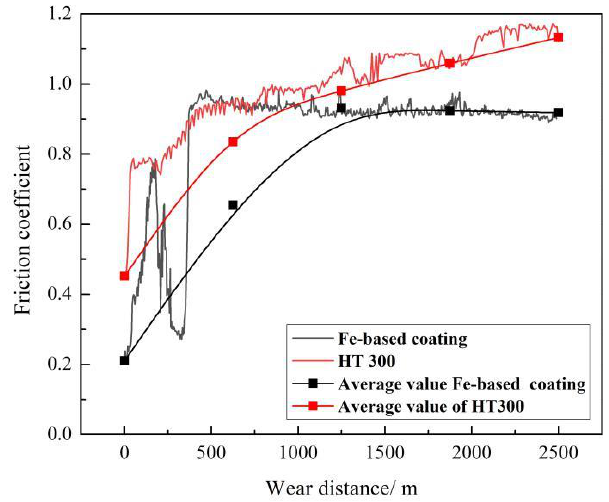
Figure 14. Friction coefficient of the coating and substrate as function of sliding distance at a given load of 100 N.